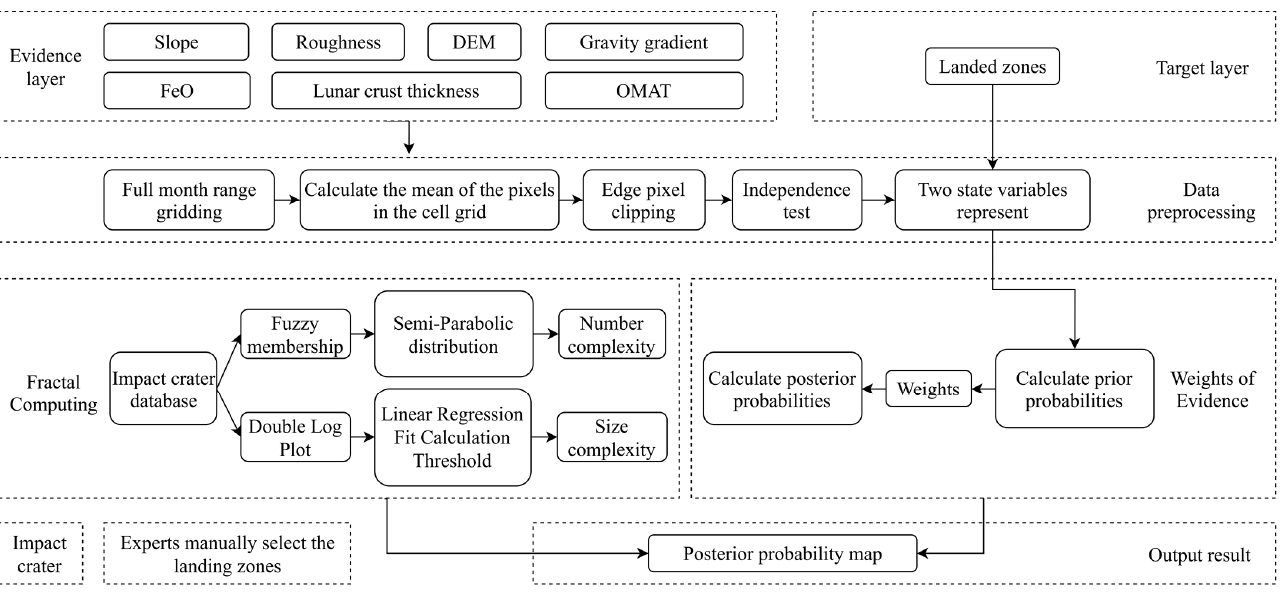
Figure 1. The overall framework of the whole-moon landing zones selection based on the weights of evidence and